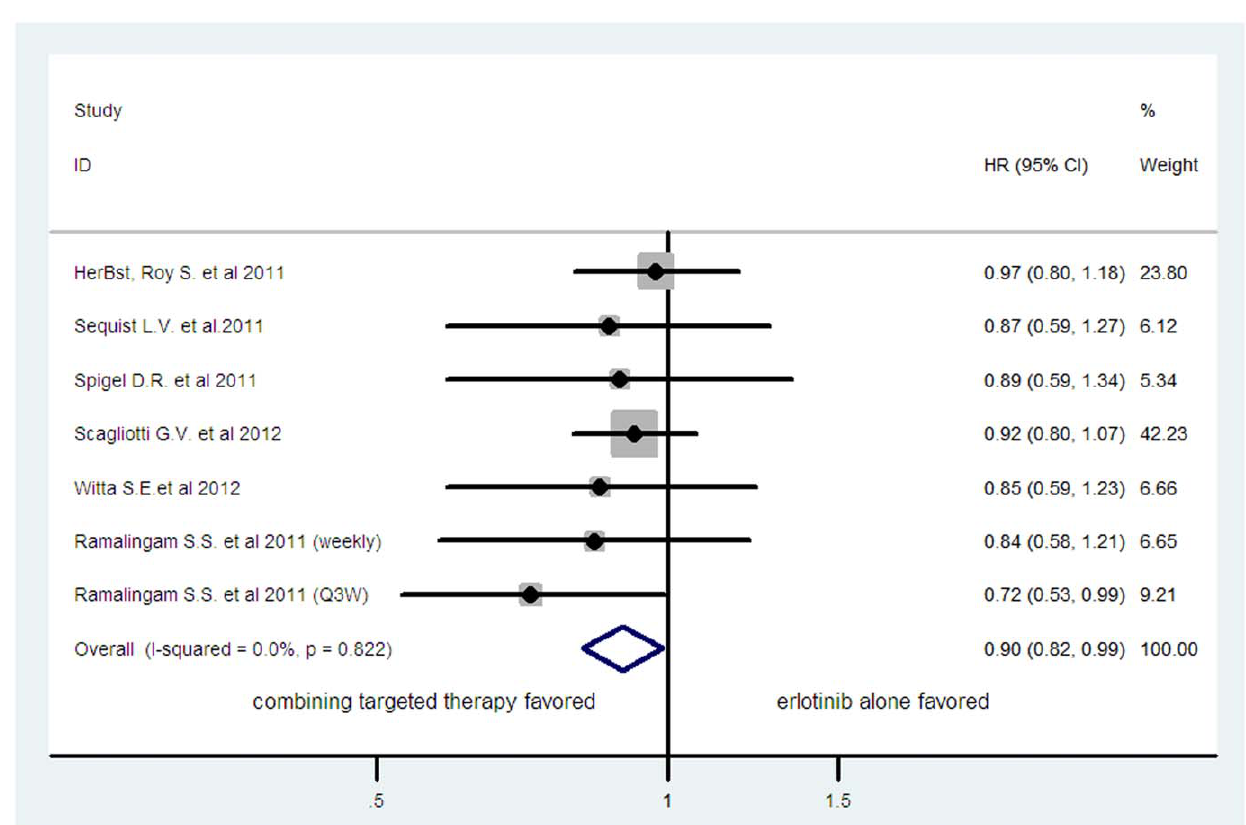
Figure 2. Comparison of OS between combining targeted therapy and erlotinib alone. doi:10.1371/journal.pone.0055637.g002 PLOS ONE |